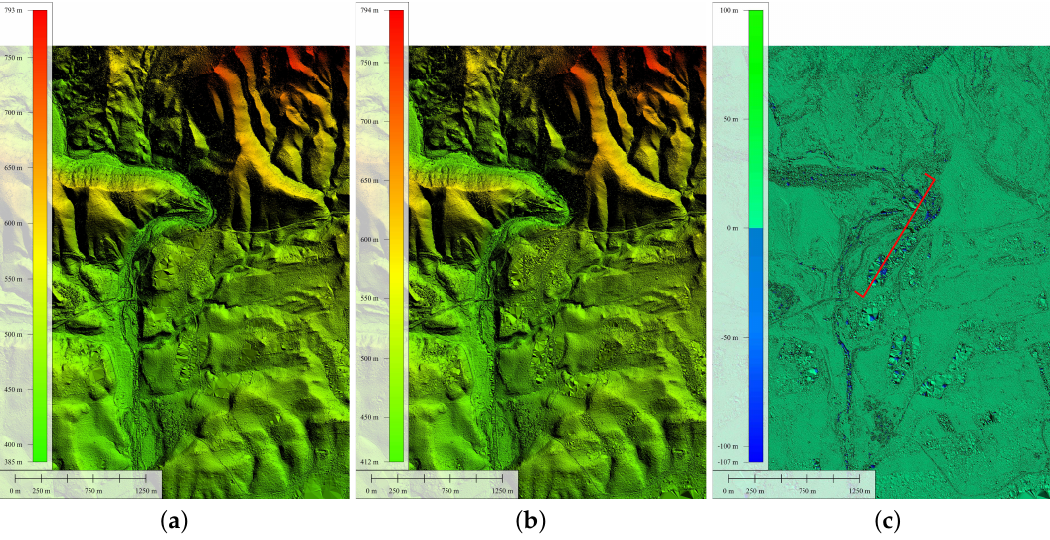
Figure 8. Comparison between the two DEMs. ( a , b ) are the panchromatic and pansharpened DEM, respectively; ( c ) is the subtraction of ( a , b ) with highlighted the zones with major defects.